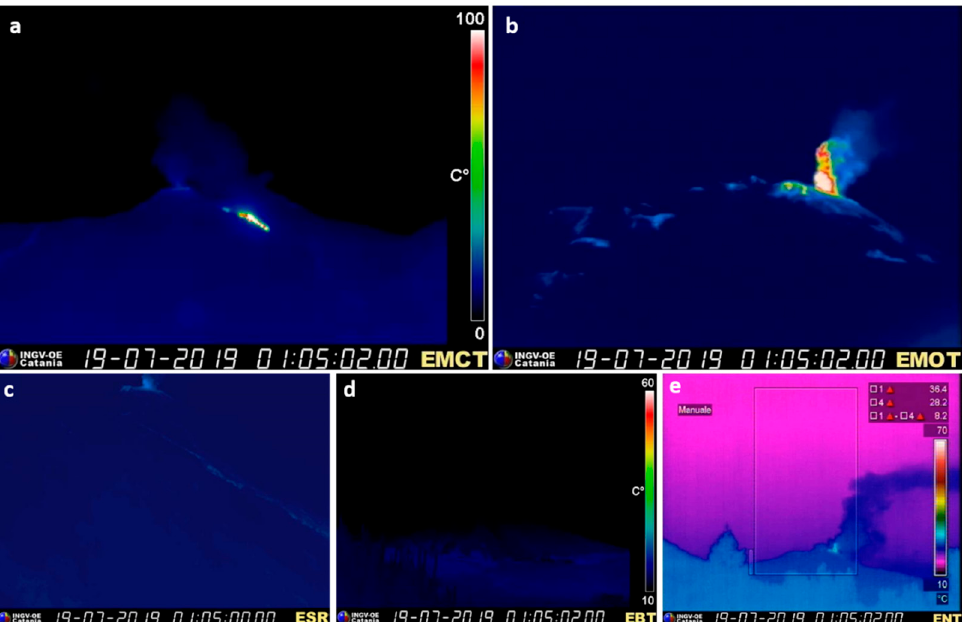
Figure 4. Raw images as acquired on 19 July, 2019 at 01:05 UTC by EMCT ( a ), EMOT ( b ), ESR ( c ), EBT ( d ) and I ( e ). The ESR camera has a lower frame rate than the others, i.e., 2 fps; for this case, the ESR image closer to the other cameras is shown. The monitored scene shows the Strombolian activity which started on the 15 of July, 2019 together with a lava flow produced by the opening of the new vent on the lower northeastern side of the NSEC on 18 July,